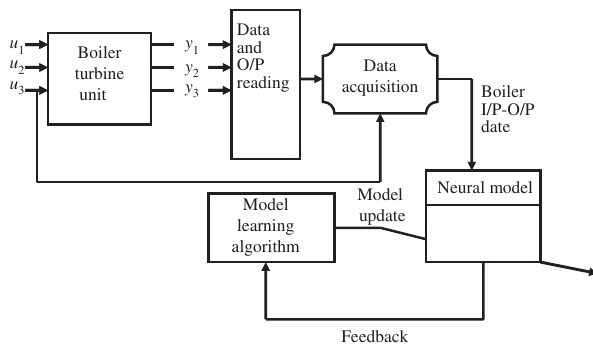
Figure 1: Intelligent Process for Boiler